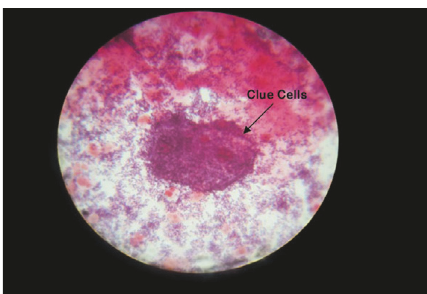
Figure 1: Clue cells on Gram-stained smear.